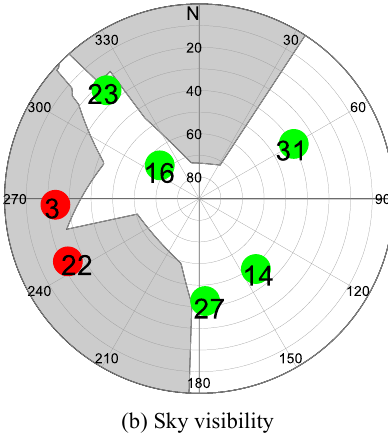
Figure 3. GPS L1 IF signal dataset collection site in Google earth and the sky visibility plotting